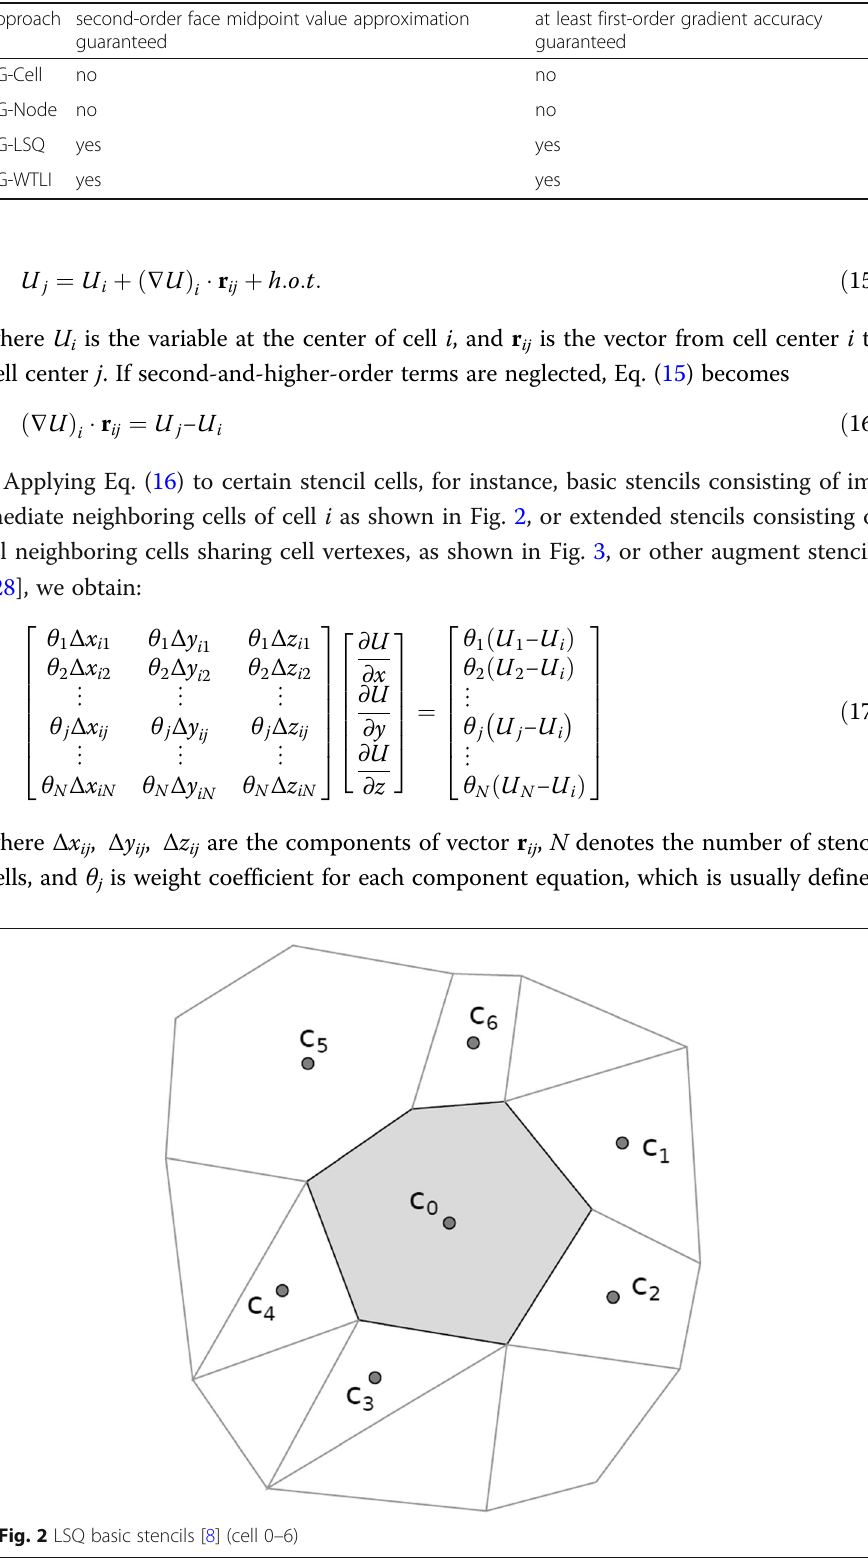
Table 1 Properties of the order of accuracy of gradient reconstruction and face midpoint value approximation on arbitrary